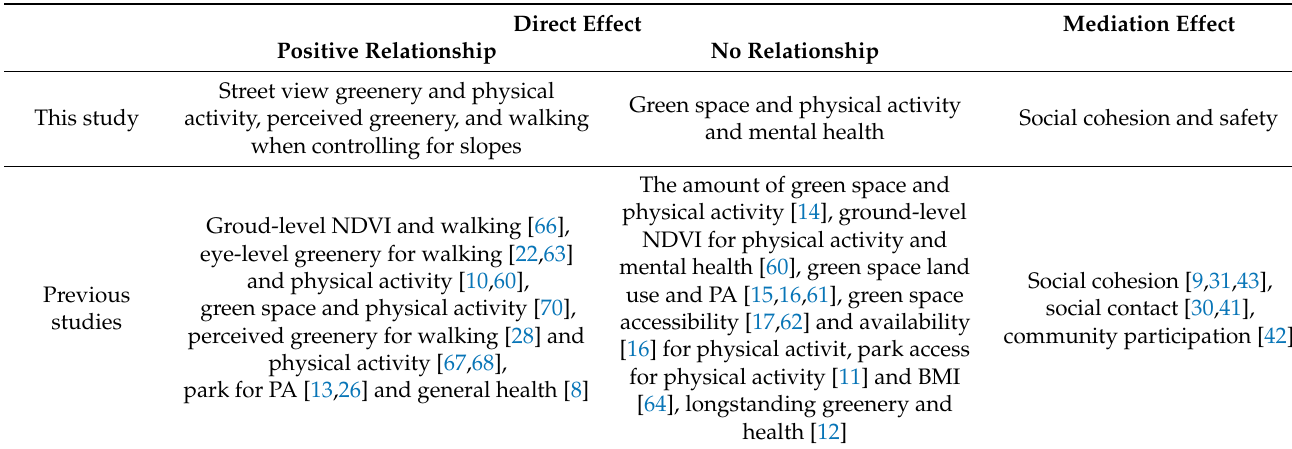
Table A3. The comparison between this study and other